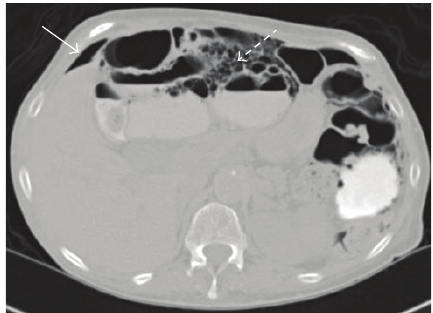
Figure 2: Axial CT image with enteric contrast demonstrates pneu- moperitoneumintherightupperquadrantoftheabdomen,anterior to the liver (arrow). Multiple large “cysts” are seen within the wall of the small bowel (dashed arrow), consistent with “pneumatosis cys- toides intestinalis” seen in this patient with scleroderma. Contrast is noted in a loop of small bowel at the left side, without extravasation of contrast from the small bowel.